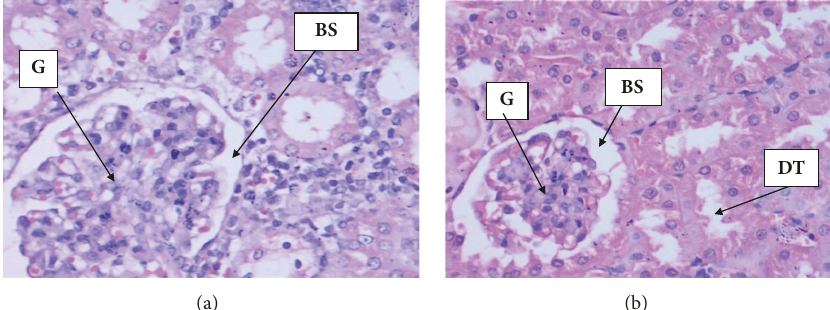
Figure 4: Photomicrographs (H&E, magnification x 40) of kidney histology. (a) Control group kidney section revealed normal glomeruli and tubules; (b) Section of kidney from L. angustifolia EO (2000 mg/kg) treated group exhibited normal glomeruli and tubules after 21 days of administration. G=Glomerulus, BS=Bowman’s Space, DT= Distal Convoluted